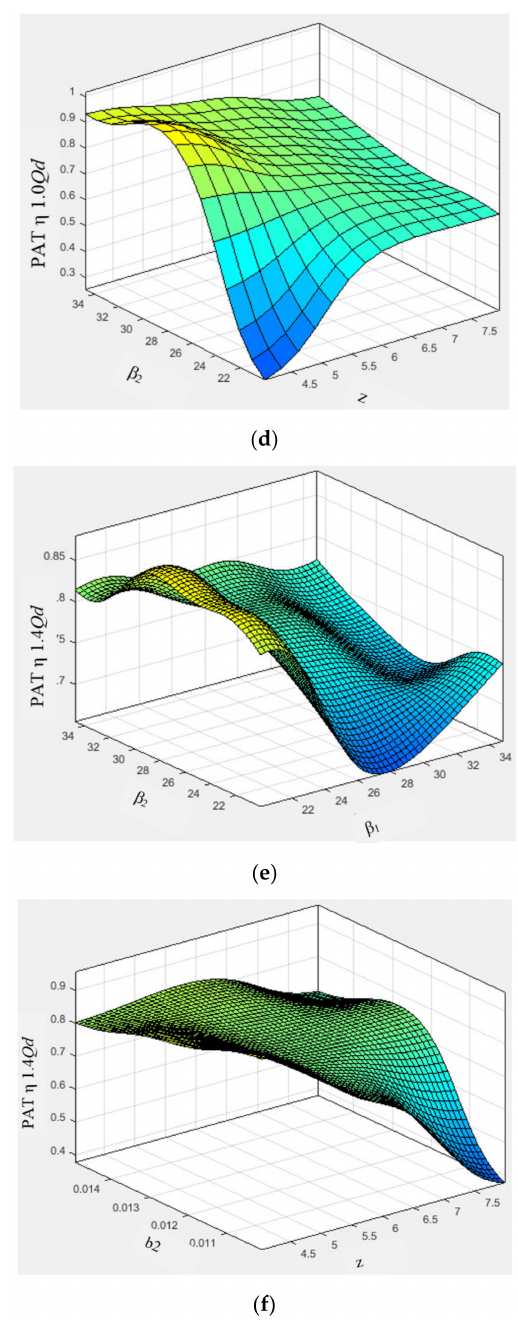
Figure 11. ( a – f ) Surface view of Sugeno-type